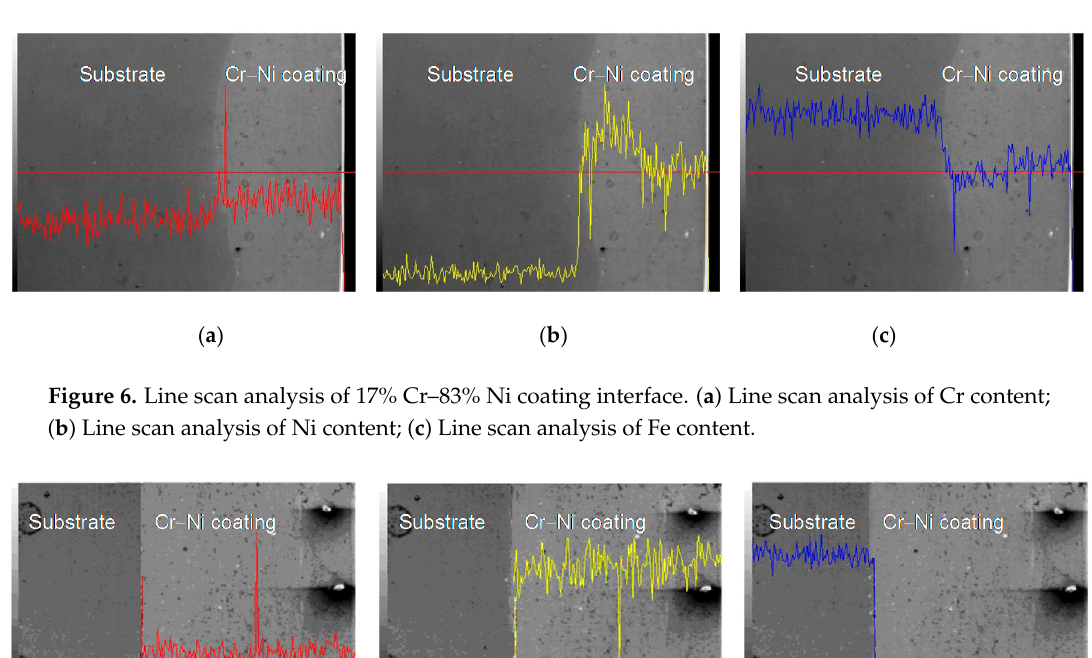
Figure 6. Line scan analysis of 17% Cr–83% Ni coating interface. ( a ) Line scan analysis of Cr content;